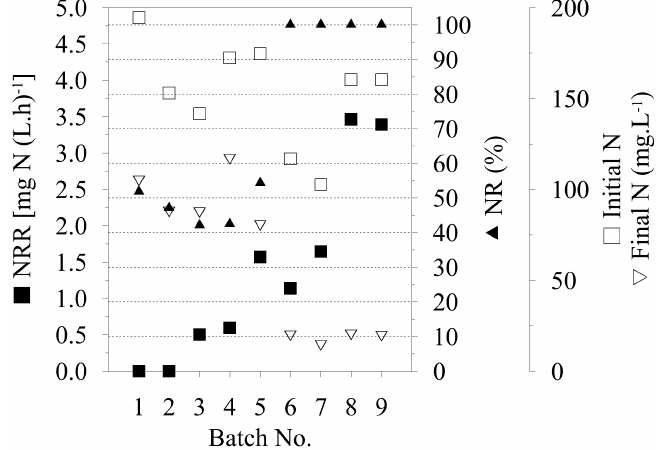
Figure 2. Nitrogen removal rate (NRR) calculated for the period 0–30 h of each biotransformation cycle, nitrogen removal (NR) calculated for entire duration of biotransformation and total, initial and final nitrogen.